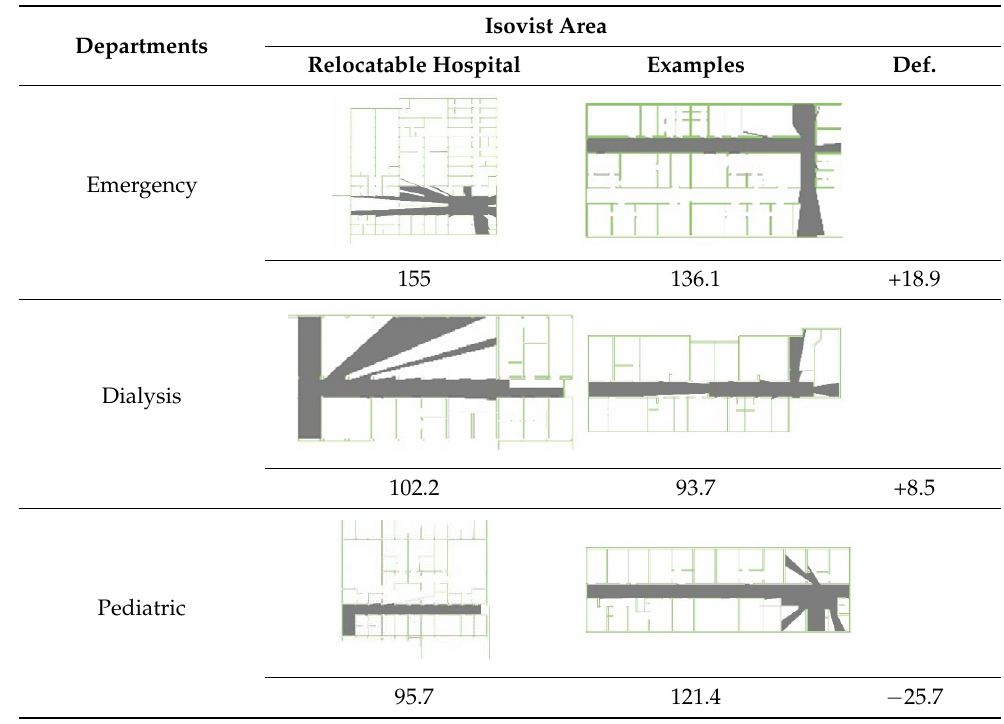
Table 12. Isovist area values and graphs of case study departments compared to examples.